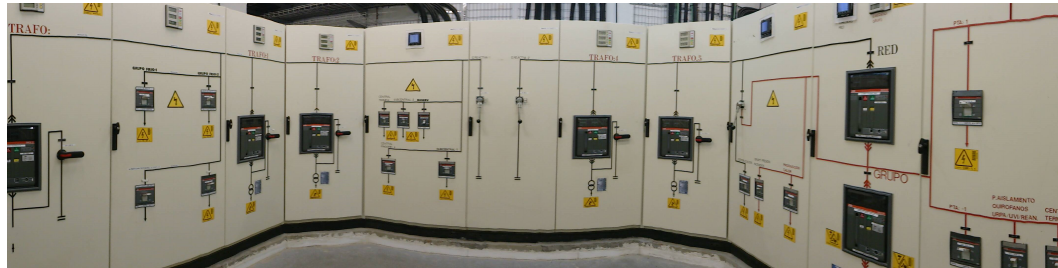
Figure 1. Photo of the output of